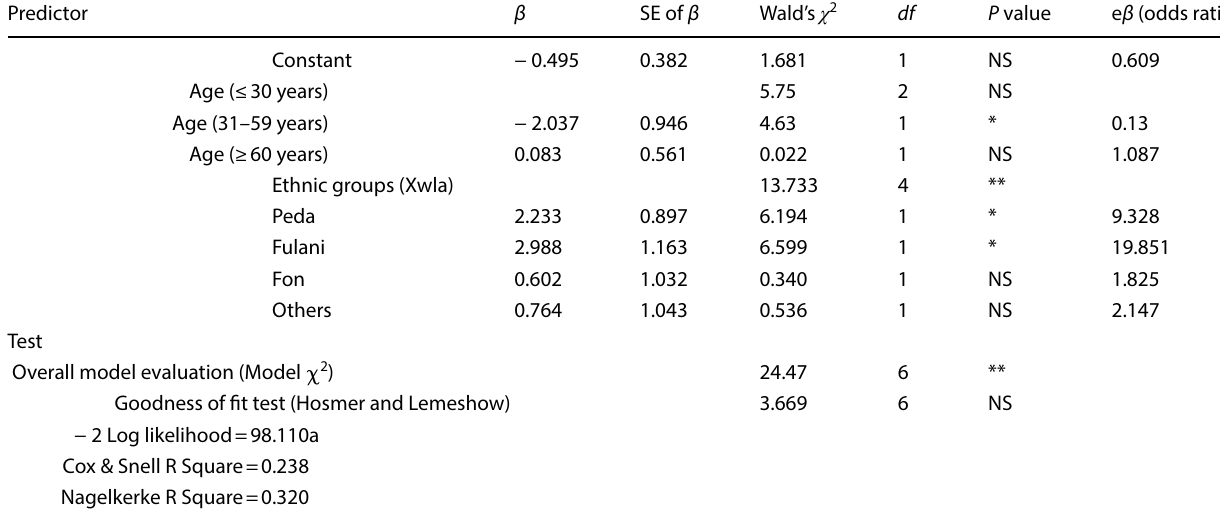
Table 5 Prediction of herders’ contribution to mangrove restoration in southern Benin by logistic regression analysis (n = 90)